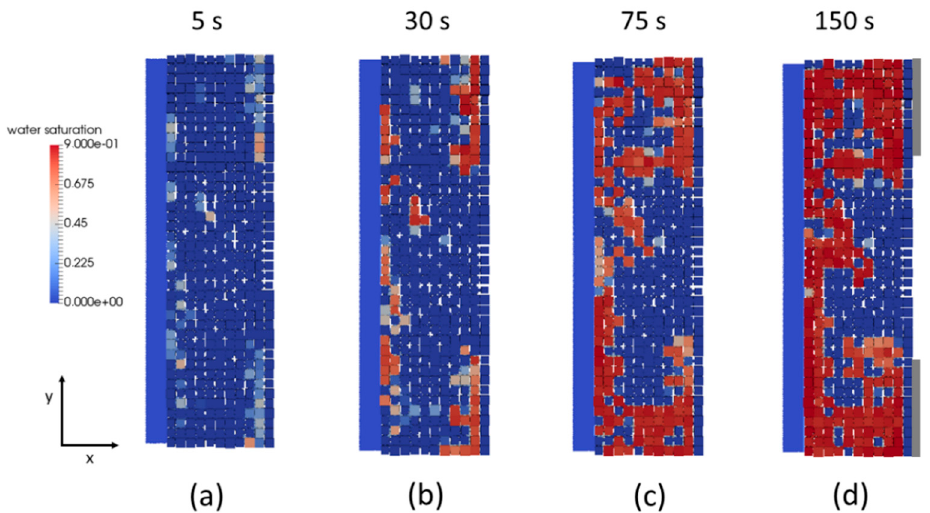
Figure 6. Temporal evolution of water saturation and liquid water clusters in the GDL in case 1.